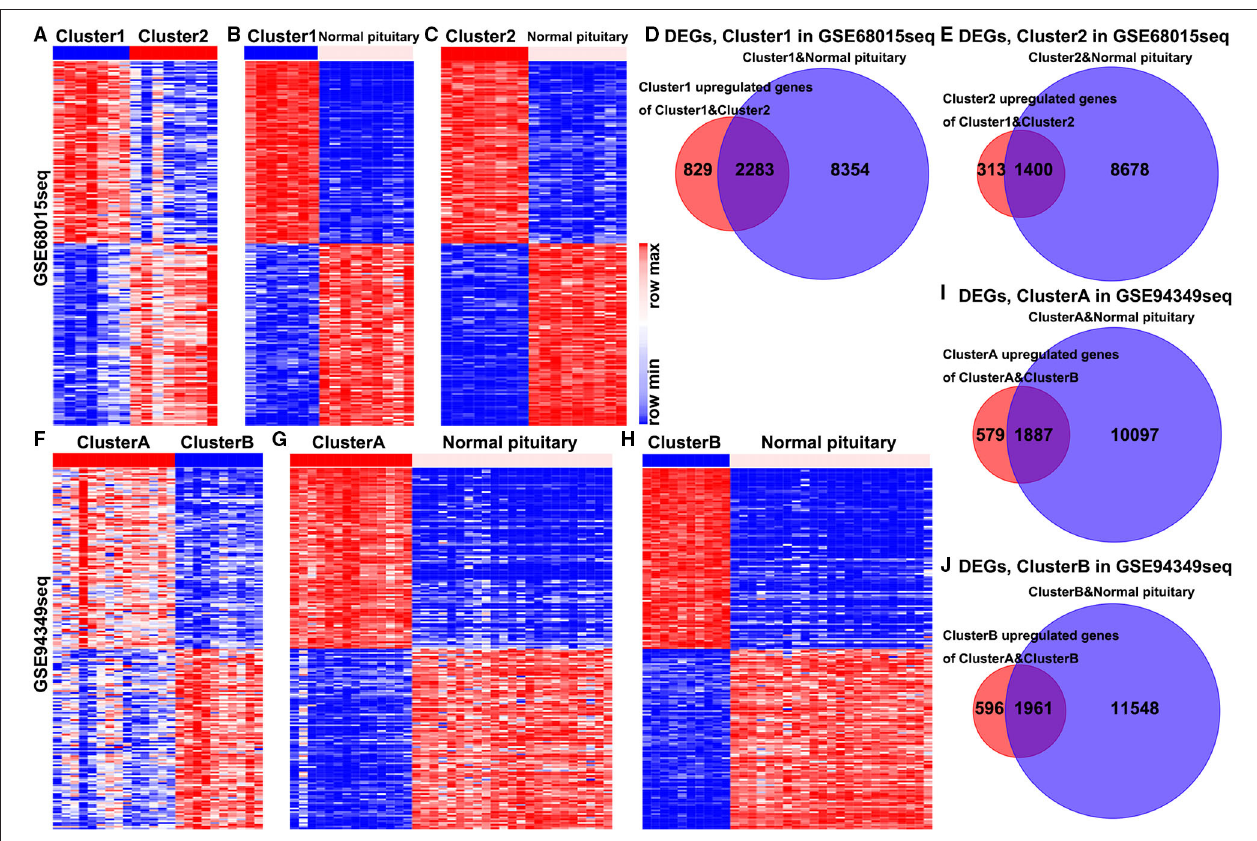
FIGURE 2 | Identification of DEGs in the IG and IR subtypes of ACPs. (A) Heat map displaying the DEGs between-group cluster 1 and cluster 2 ACPs in the GSE68015 database. The heat maps display the DEGs between (B) cluster 1 and normal pituitary, (C) cluster 2 and normal pituitary. (D) A total of 3,112 cluster 1 upregulated genes were compared with 10,637 DEGs between the cluster 1 and normal pituitary groups, yielding a set of 2,283 overlapping genes. (E) A total of 1,713 cluster 2 upregulated genes were compared with 10,078 DEGs between the cluster 2 and normal pituitary groups, yielding a set of 1,400 overlapping genes. (F) Heat map displaying the DEGs between-group cluster A and cluster B ACPs in the GSE94349 database. The heat maps display the DEGs between (G) cluster A and normal pituitary, (H) cluster B and normal pituitary. (I) A total of 2,466 cluster A upregulated genes were compared with 11,984 DEGs between cluster A and normal pituitary groups, yielding a set of 1,887 overlapping genes. (J) A total of 2,557 cluster B upregulated genes were compared with 13,509 DEGs between the cluster B and normal pituitary groups, yielding a set of 1,961 overlapping